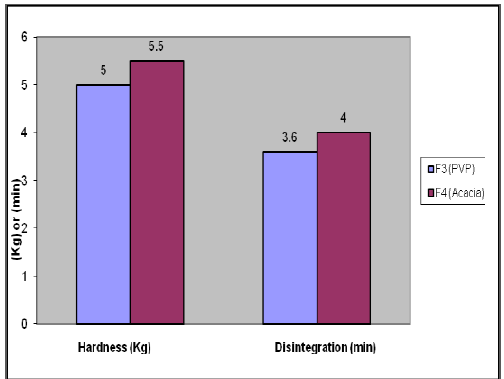
Figure 2: Effect of different binder on the hardness and disintegration time of formulas F3 (PVP) and F4 (Acacia) Bisoprolol